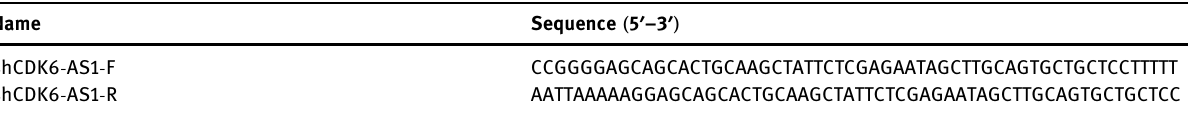
Table 1: The primers for construction of plasmid Name Sequence ( 5 ′– 3 ′ ) shCDK6 - AS1 - F shCDK6 - AS1 - R